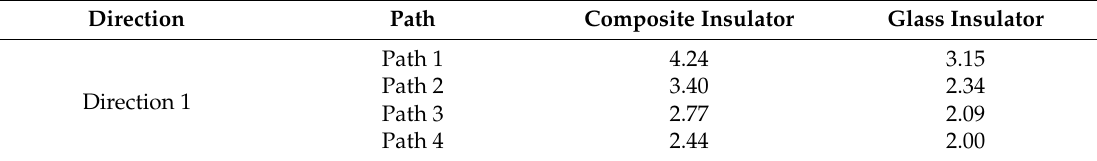
Table 3. The uneven coefficients of electric